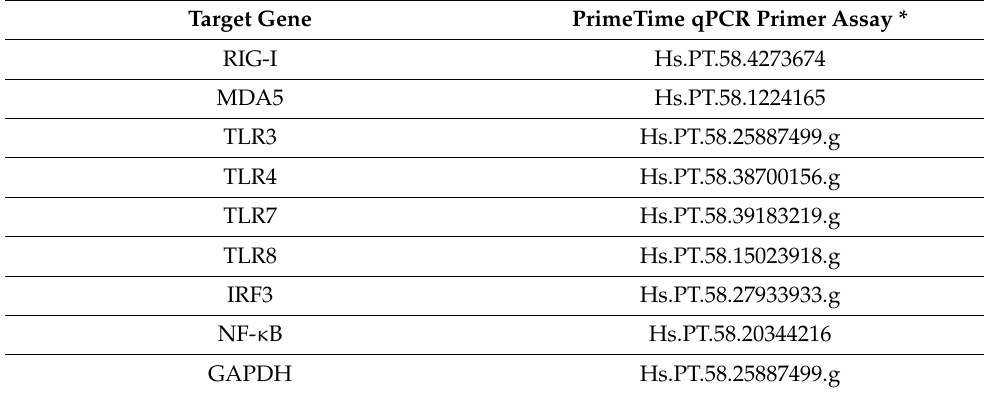
Table 1. PrimeTime qPCR assays used for gene expression